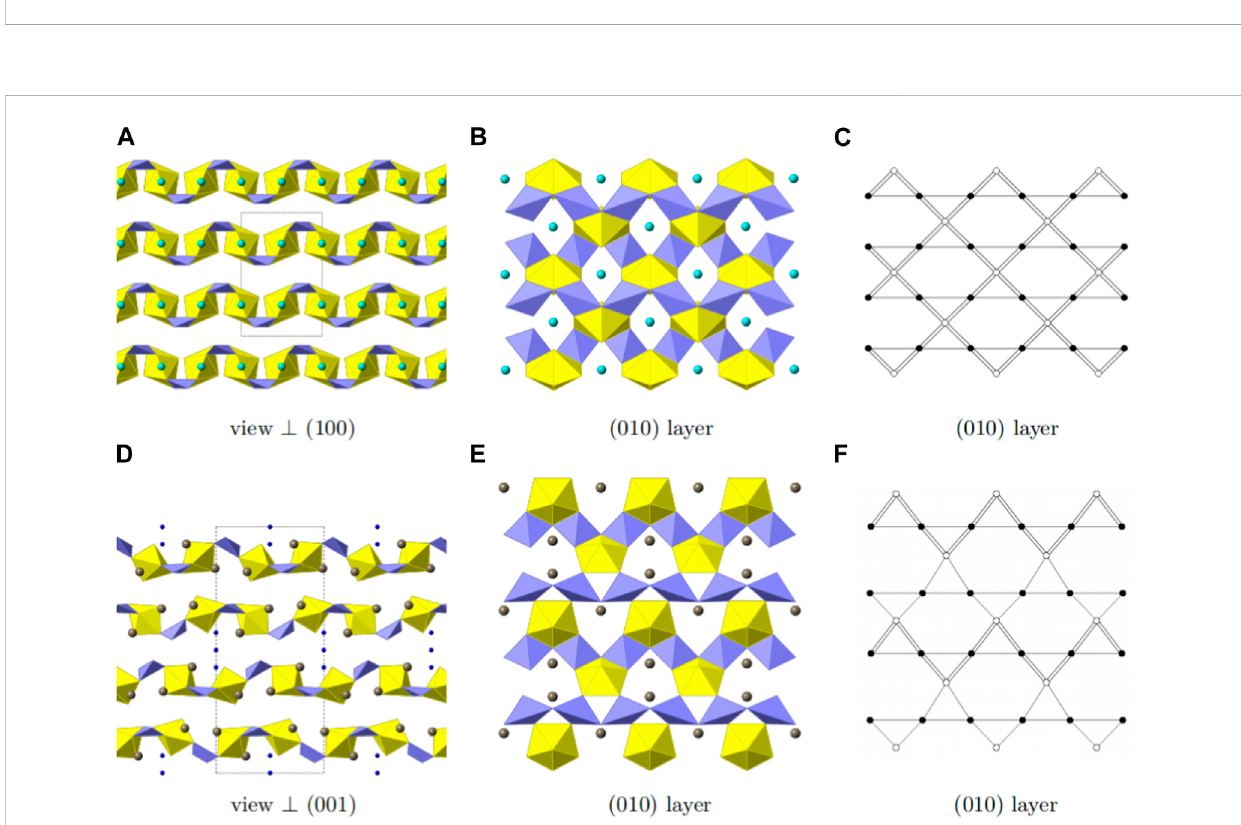
FIGURE 4 Structural and topologic depiction of Mg [(UO 2 ) (TeO 3 ) 2 ] (A – C) and in comparison Tl 3 ((UO 2 ) 2 (Te 2 O 5 (OH)) (Te 2 O 6 ))?2(H 2 O) (D – E) . In (A) and (D) a sideview ofthestructureoftheformerand thelatter canbeseen.The unit-cell outline isshown indashed-lines. InMg[(UO 2 )(TeO 3 ) 2 ],an ABAB ordering principleisvisiblewhereasan ABCDABCD isfoundinTl 3 ((UO 2 ) 2 (Te 2 O 5 (OH))(Te 2 O 6 )) · 2(H 2 O).In (B) and (E) asingle(010)layerforbothstructuresisshown andtheaccording topology isdepictedin (C) and (F) ,respectively. UO 7 polyhedraaredepictedinyellow, TeO 4 polyhedra inlightpurple, Mgincyan, Tl in grey and water molecules in deep